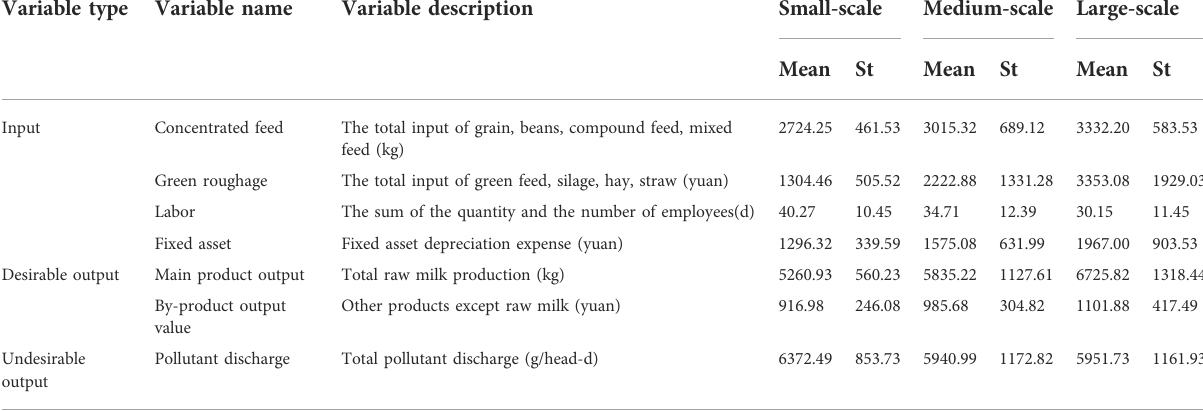
TABLE 1 Explanation and descriptive statistics of variables Variable type